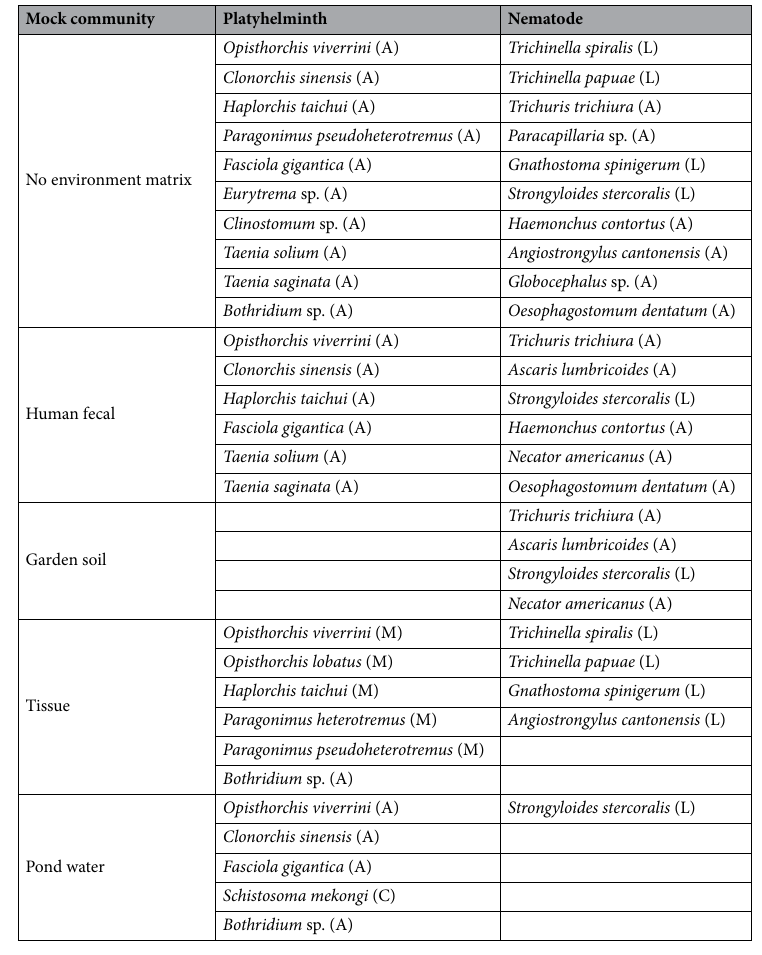
Table 1. Helminth taxa and stages included in each type of mock community. The stages of each specimen are in parentheses, with adult = A, larva = L, metacercaria = M, and cercaria =